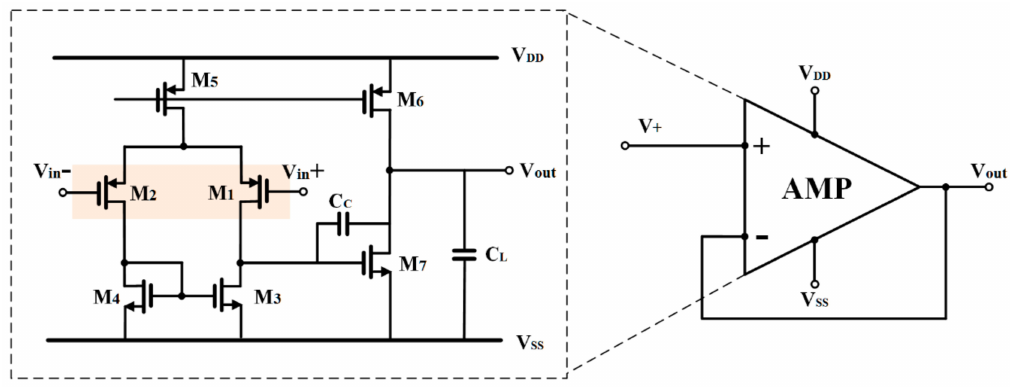
Figure 6. Single-event transients (SET) simulation circuit consisting of an operational amplifier in voltage follower configuration (M1 and M2 modeled in BTS and normal